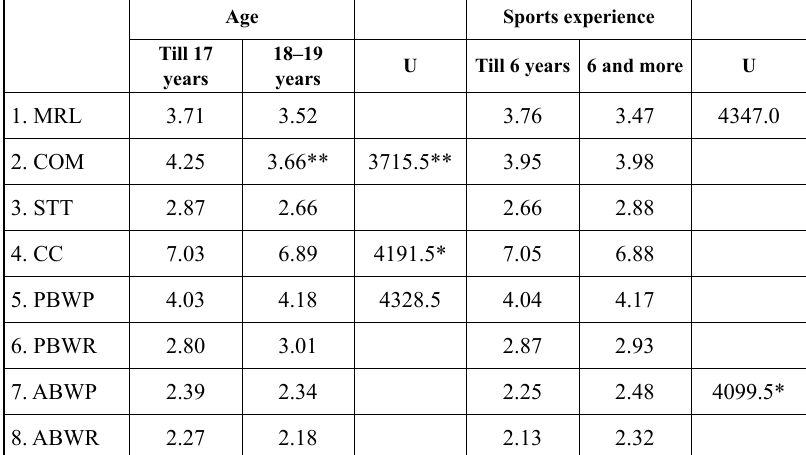
Table 4. Athletes’ values, prosocial and antisocial behaviors, and the evaluation of coach’s competence to develop character in the aspect of their age and sports